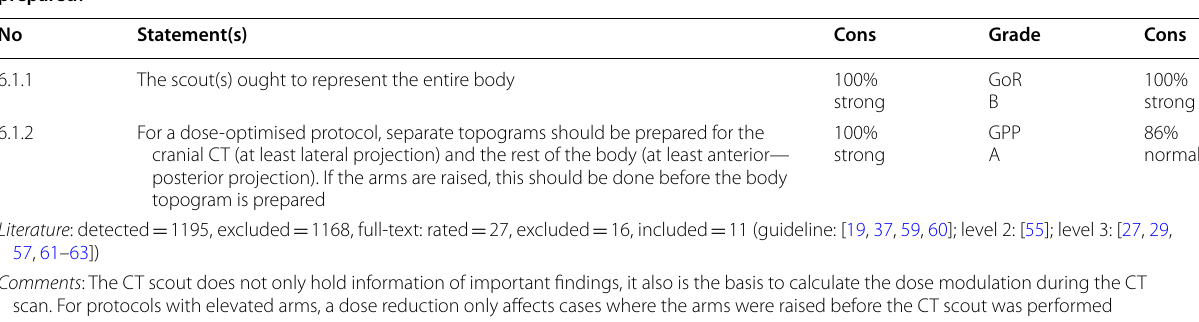
Table 10 Section 6: Whole Body CT – Protocol, key issue 1: CT